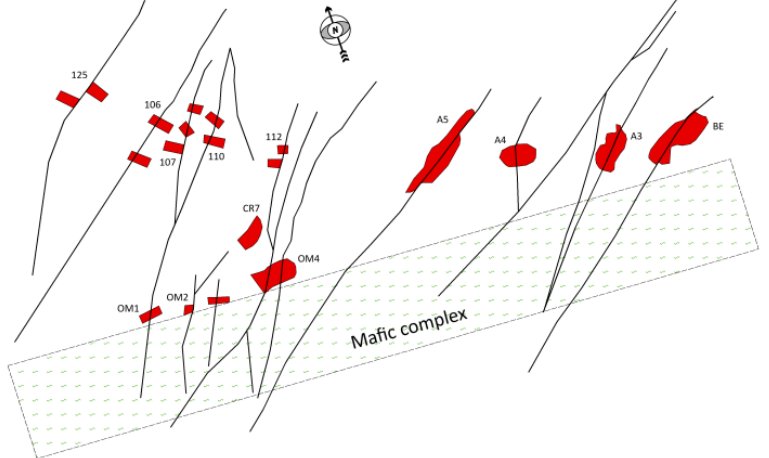
Figure 8. The pattern of fracturing that controls Bleïda sulfide bodies modified after [53].